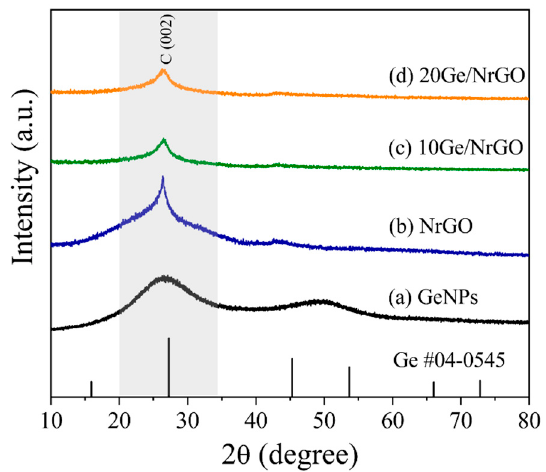
Figure 4. ( a ) XRD patterns of prepared products with Ge database reference inset; ( a ) GeNPs, ( b ) NrGO, ( c ) 10Ge/NrGO, and ( d ) 20Ge/NrGO.